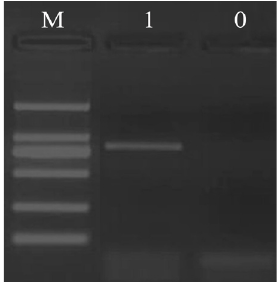
Fig. 3. Nested PCR for identification of the S. nitidum ; M: